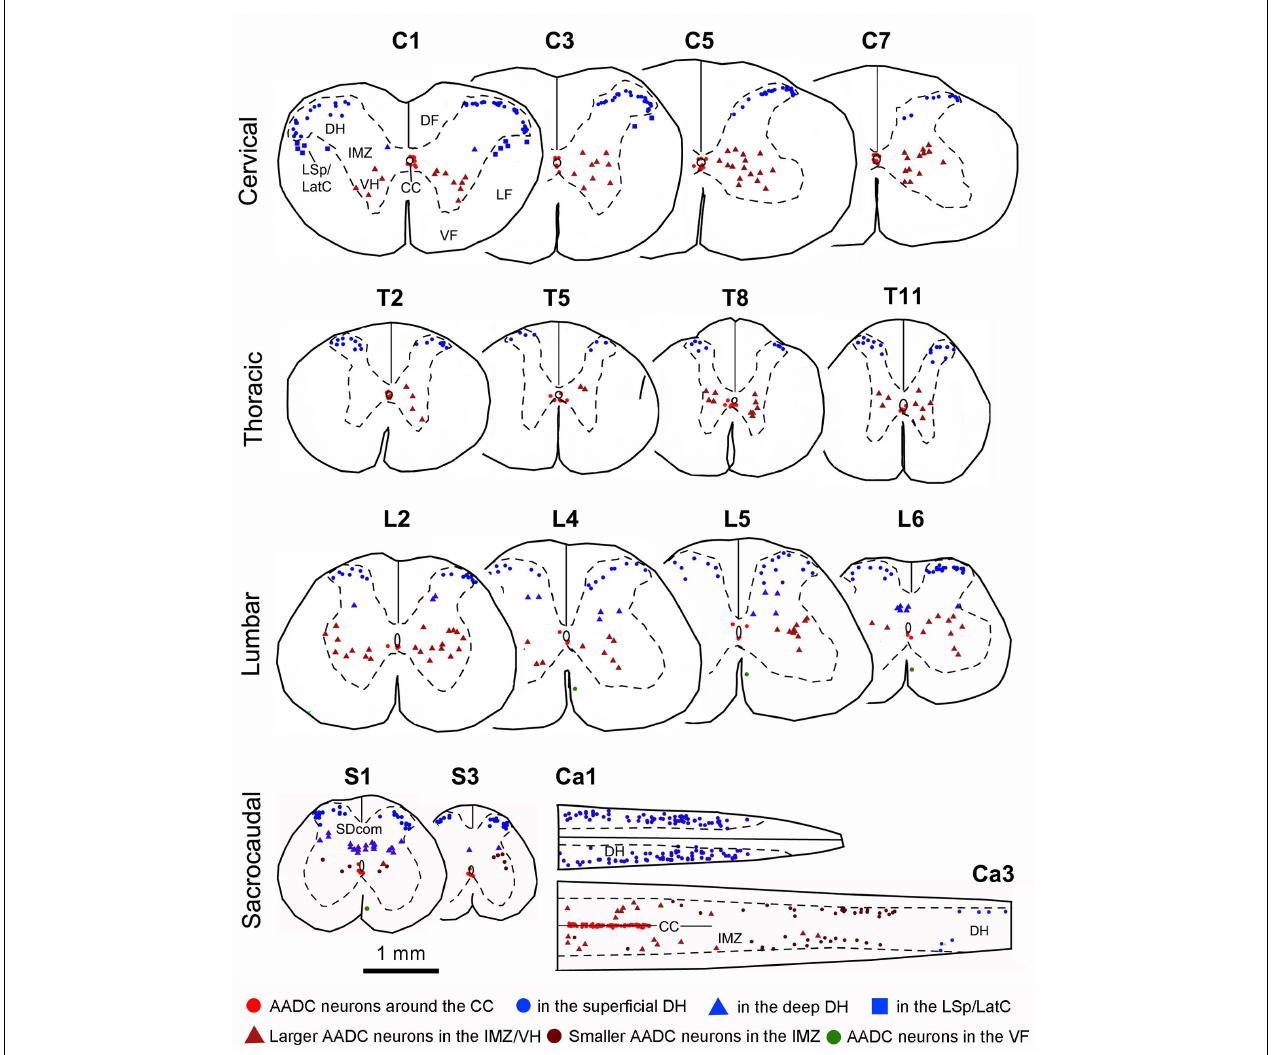
FIGURE 9 | Plots of AADC cells in different segments of the spinal cord. Shown are the representative sections from C, T, L, S, and Ca segments from one rat. The segment level is indicated above each section. Sections from C1 to S3 levels were transverse and the two sections from Ca1 to Ca3 levels were horizontal. Of the horizontal sections, the top one is through the superficial DH and the bottom one is partly through the CC and partly the IMZ. DF, dorsal funiculus; LatC, lateral cervical nucleus; LSp, lateral spinal nucleus; LF, lateral funiculus; SDcom, sacral dorsal commissural nucleus; VF, ventral funiculus; VH, ventral horn. Because AADC neurons in the VF were not plotted, for the purpose of illustration, they were manually placed in L4, L5, and S1 sections (green dots) (please refer to Figure 11 ). Spinal sections used for plotting were immunostained with rabbit AADC antibody. Bar below sections S1 and S3, valid for all panels, 1